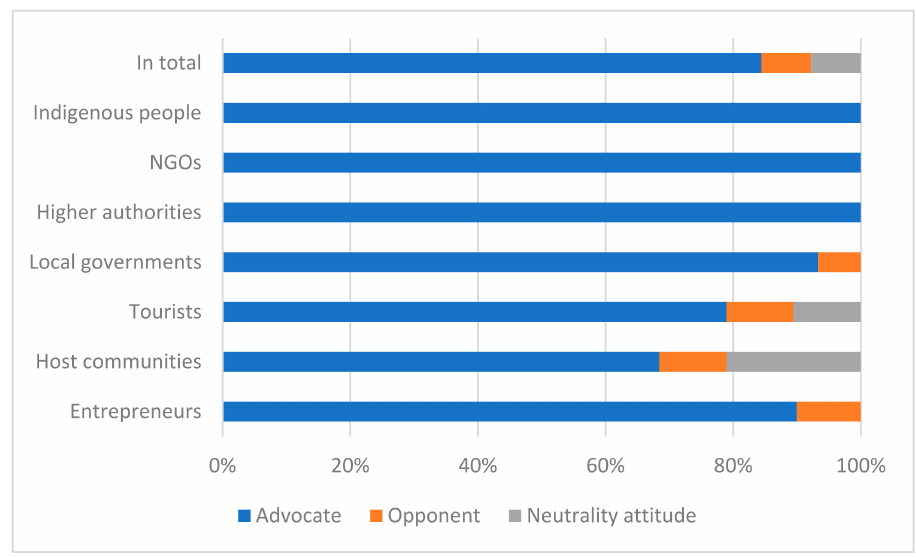
Figure 3. Stakeholders’ views on cultural integration into rural